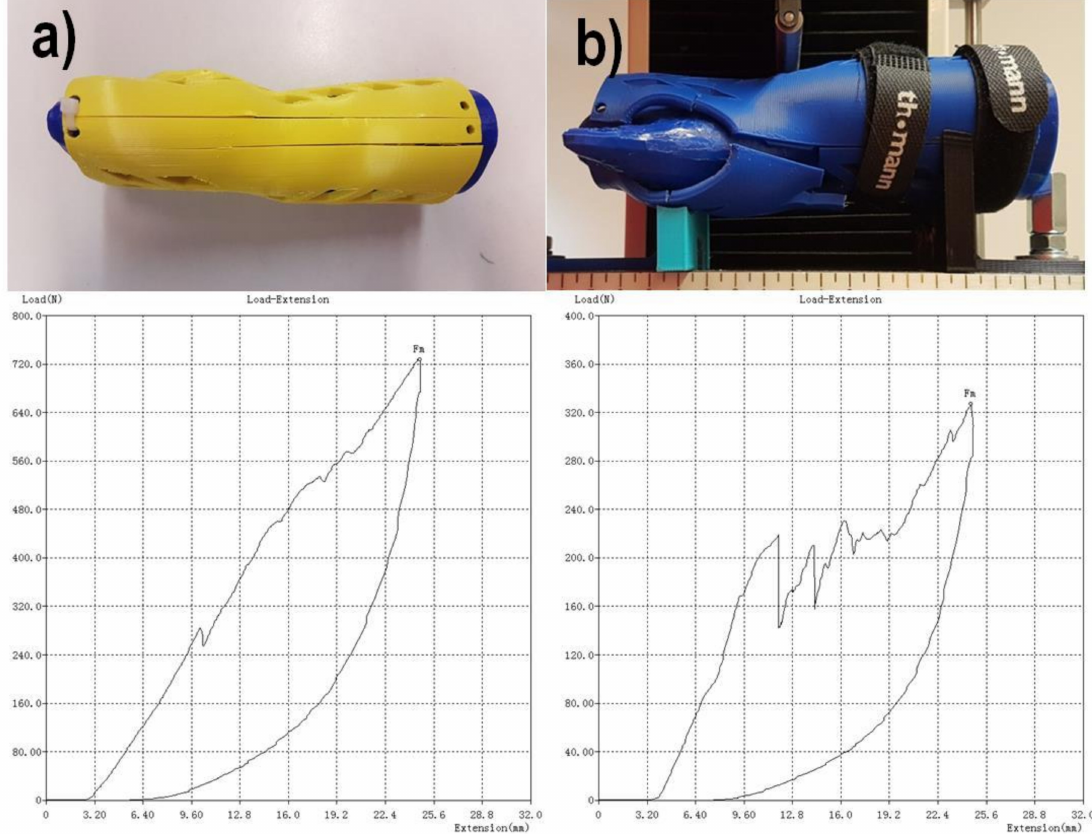
Figure 19. Di ff erent mechanisms of failure (ABS, econo), ( a )—horizontal orientation, ( b )—vertical orientation, juxtaposed with force–displacement diagrams (below the